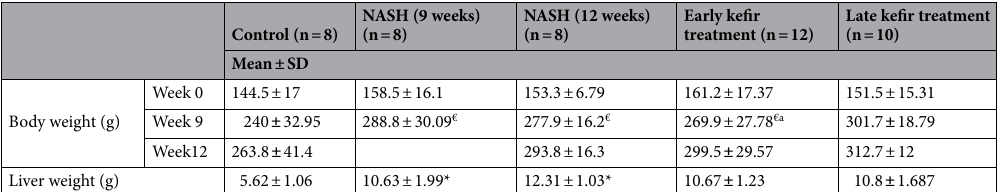
Table 2. The effect of kefir milk on body weight and liver mass in different study groups. Values are mean ± SD; n: number of animals = 8 rats/each group. One-Way ANOVA test followed by Tukey’s multiple comparison test. *P < 0.001 compared to control group. # P < 0.001 compared to NASH (9 weeks) group. δ P < 0.001 compared to NASH (12 weeks) group. a P < 0.001 compared to Late Kefir. € P < 0.05 compared to control group.